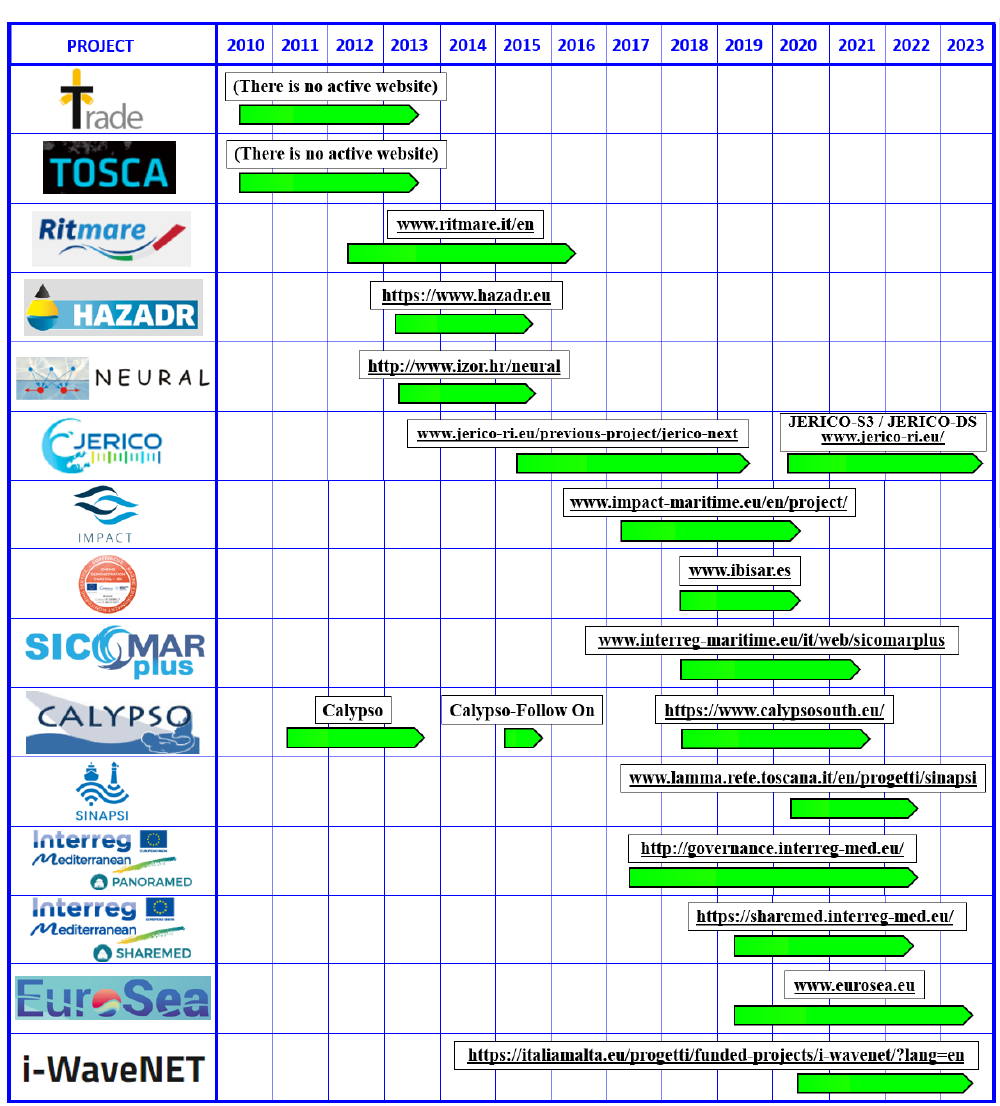
Figure 10. Gantt diagram showing the timeline of past and ongoing projects dealing with HFR technology in the Mediterranean Sea. The official logo and the web link (if available) for each project are